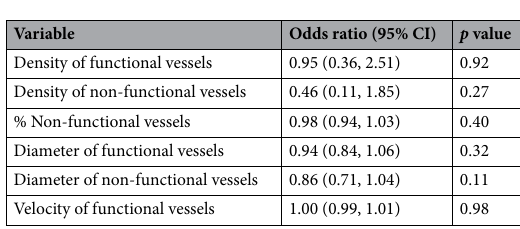
Figure 2. HIVM observations from non-tumor (left panel) and tumor (right panel) areas obtained from a current smoker ( A ) and from a patient who received pre-operative radiotherapy ( B ). There was a similar proportion of non-functional vessels between the tumor and non-tumor areas in the current smoker, suggesting pre-existing background changes in the microvasculature due to smoking use. In patients who received pre- operative radiotherapy (n = 3), there was a high proportion of non-functional vessels observed (64.7%). These findings suggest that radiation-induced changes had affected the tumor microvasculature.